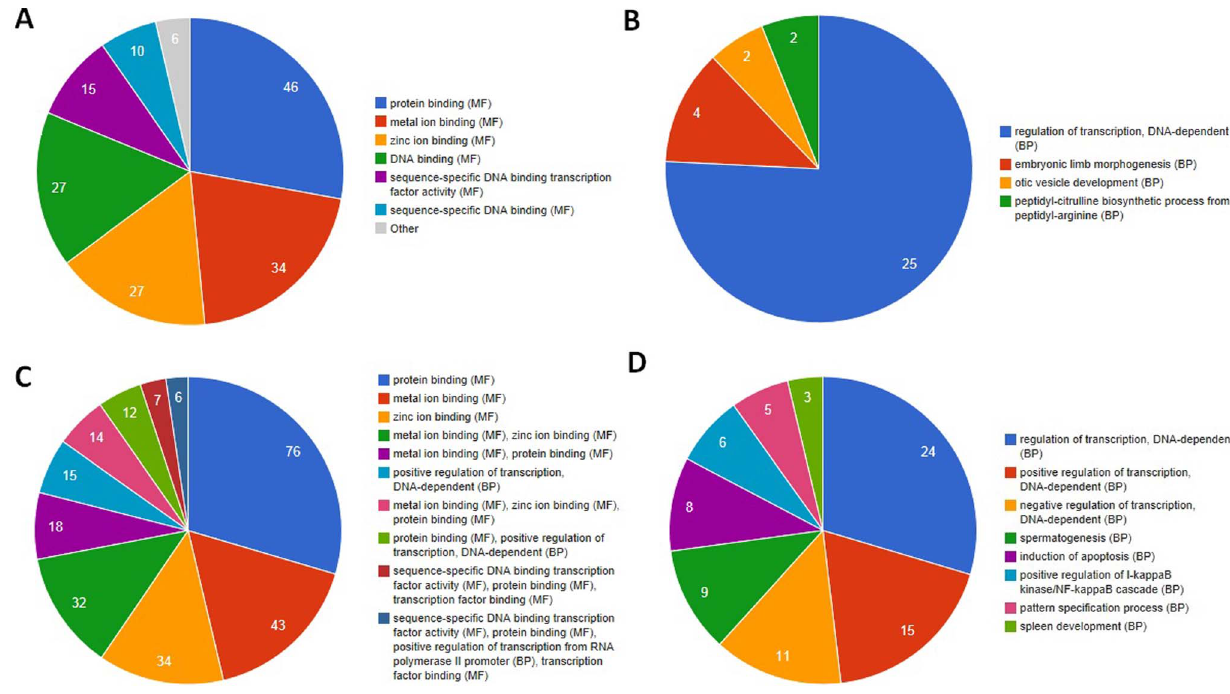
Figure 3. Enriched GO terms of differentially expressed genes between RA and OA vs. NT samples. (A) molecular functions for differentially expressed genes of RA vs. NT samples; (B) biological process for differentially expressed genes of RA vs. NT samples; (C) molecular functions for differentially expressed genes of OA vs. NT samples; (D) biological process for differentially expressed genes of OA vs. NT samples.